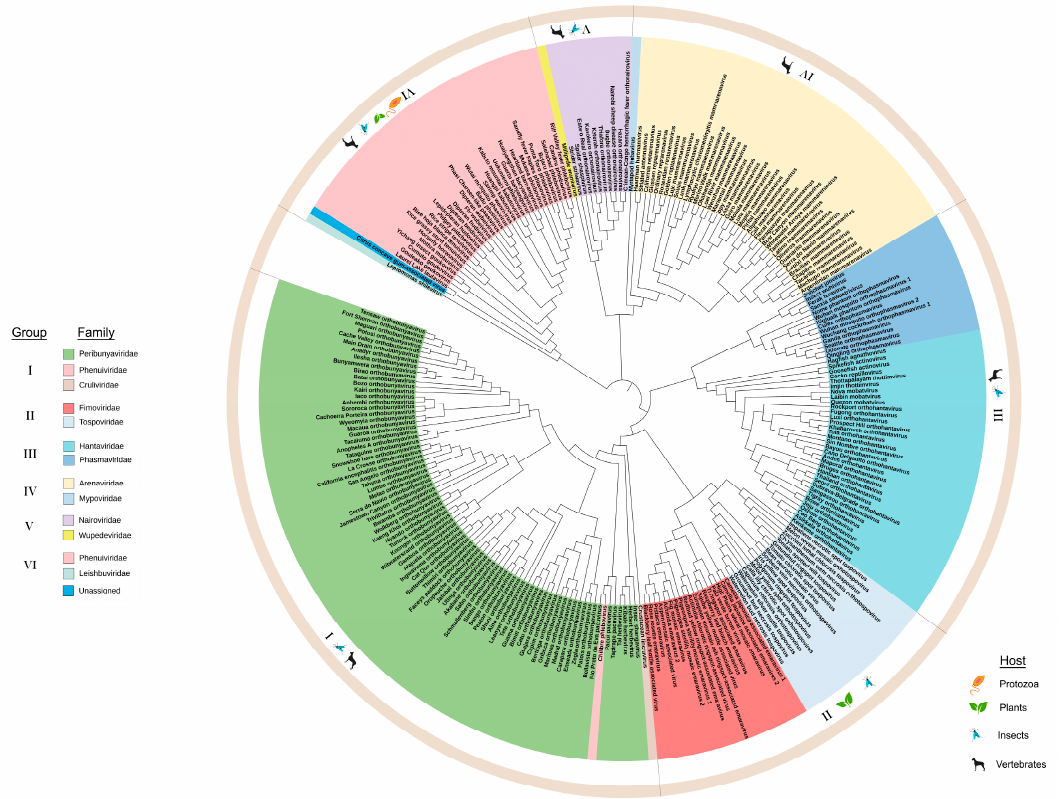
Figure 1. Maximum likelihood phylogenetic tree of the amino acid sequences of the RNA-dependent RNA polymerase (RdRp). The virus families are color-coded and the hosts for viruses within each group are indicated in the outermost circle. The six groups are identified in the legend and the boundaries of these groups are indicated in the outer ring of the phylogeny. Group I: Peribunyaviridae , Phenuiviridae , and Cruliviridae . Group II: Fimoviridae and Tospoviridae . Group III: Hantaviridae and Phasmaviridae . Group IV: Arenaviridae and Mypoviridae . Group V: Nairoviridae and Wupedeviridae . Group VI: Phenuiviridae , Leishbuviridae , and unassigned species. Clade validation is based on the approximate likelihood ratio test (aLRT)-Shimodaira–Hasegawa (SH)-like test values. The third major branch has the invertebrate-infecting species Leptomonas shilevirus and Laurel Lake virus at the deepest